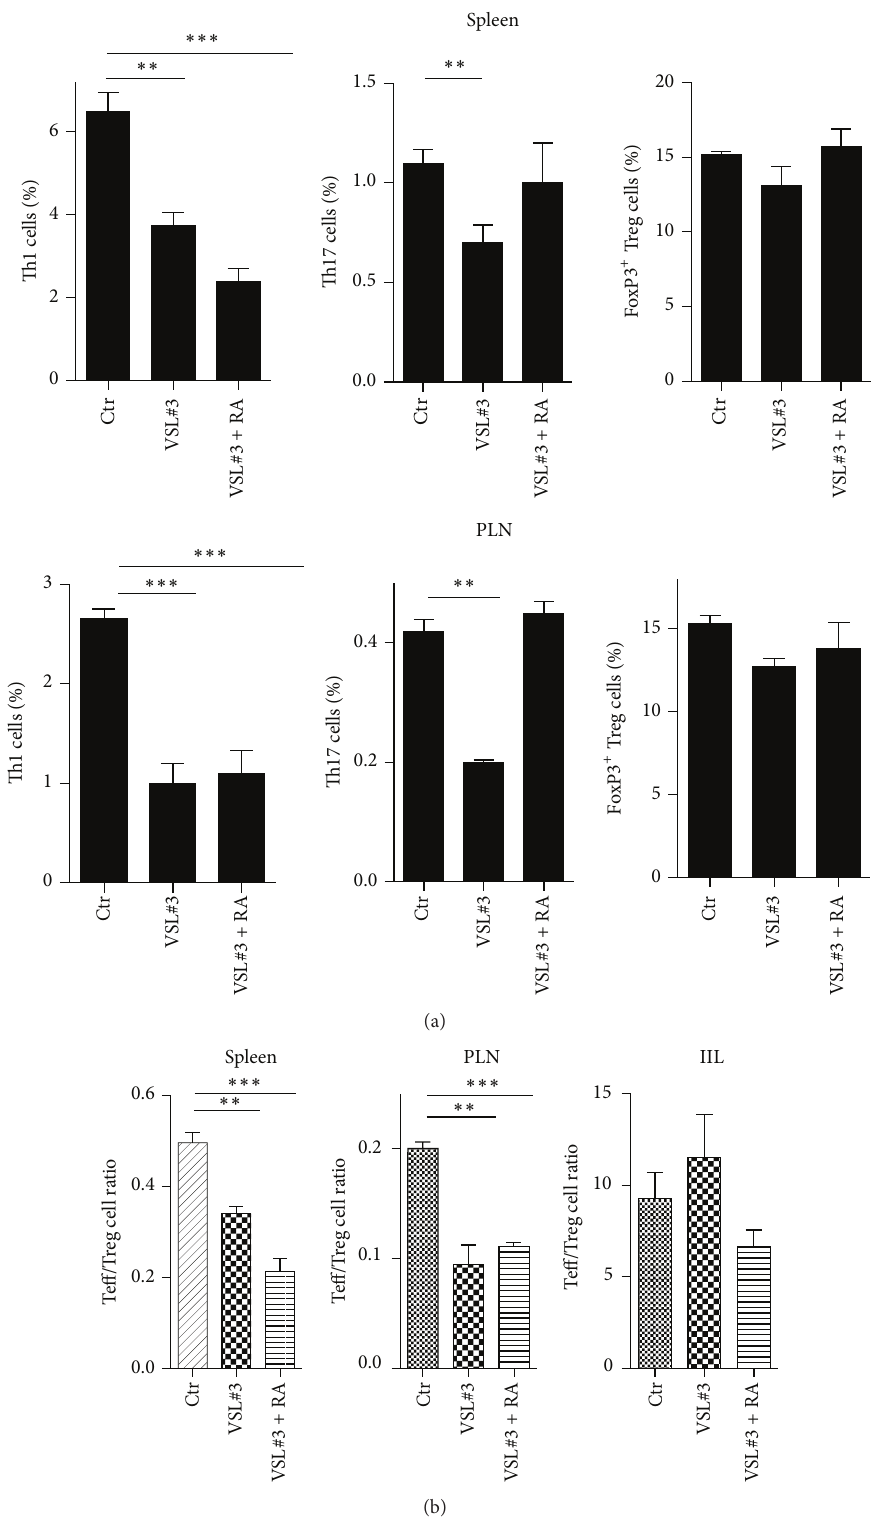
Figure 5: Restoration of immune homeostasis in the intestinal mucosa of VSL#3-treated NOD mice led to reduced Teff/Treg cell ratios at the systemic level as well as within the pancreatic lymph nodes (PLN) of NOD mice. (a) The percentages of different T helper cell subsets were measured in the total splenocytes (spleen) and PLN cells. Spleens and PLN were isolated from untreated (Ctr), VSL#3-treated (VSL#3), and VSL#3 + RA-treated NOD mice at 12 weeks of age ( 𝑛 = 4 ). The percentages of Th1, Th17, and FoxP3 + Treg cells were measured and expressed as the mean ± SEM. (b) The percentages of different T helper cell subsets were measured in the splenocytes (spleen), PLN cells, and islet infiltrating lymphocytes (IIL). The data are expressed as the Teff (Th1 + Th17)/Treg cell ratios. ∗∗∗ 𝑝 < 0.0005 , ∗∗ 𝑝 < 0.005 by Student’s 𝑡